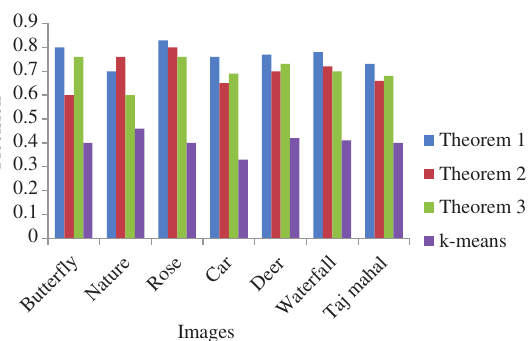
Figure 8: Performance Analysis of Different Approaches Using Precision